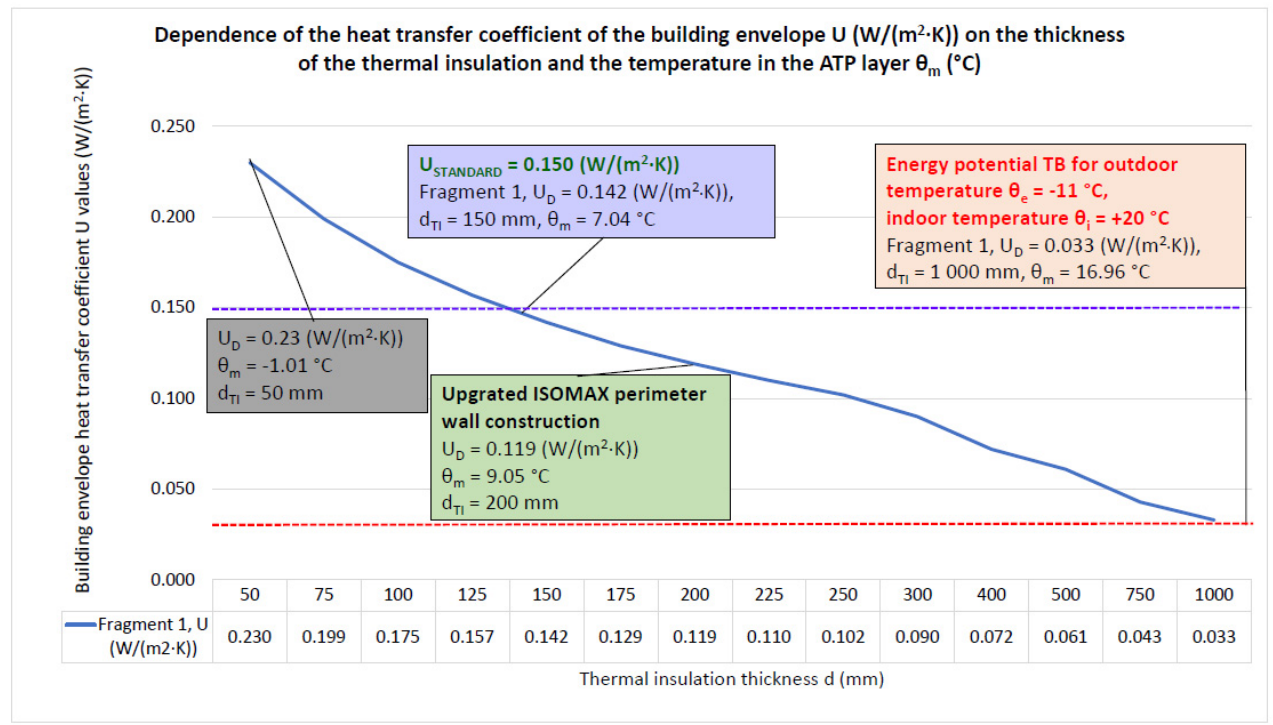
Figure 14. Dependence of the dynamic heat coefficient U D (W/(m 2 · K)) on the thickness of the thermal insulation and the mean temperature θ m (°C) in the ATP layer—Fragment 1.